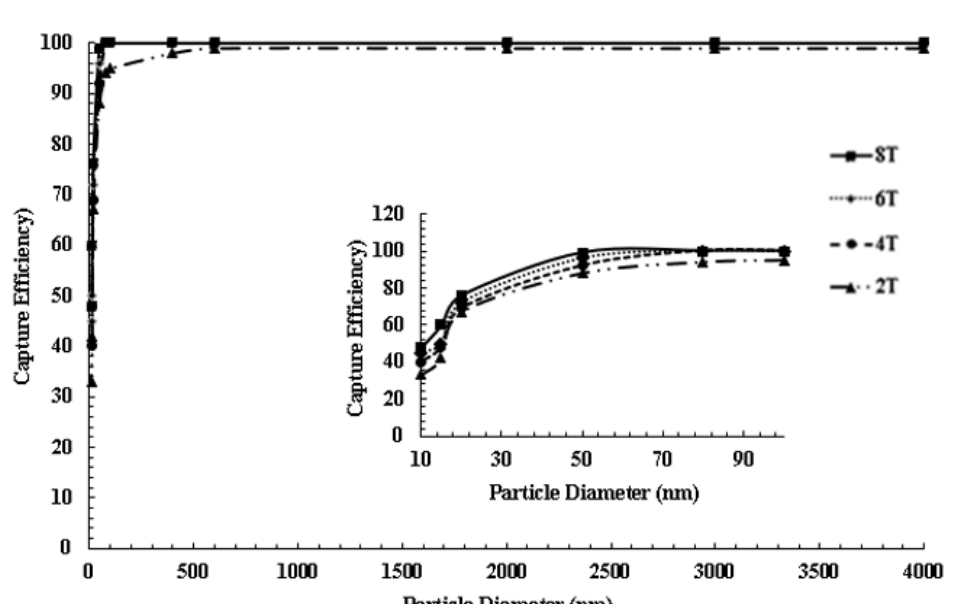
Figure 12. Plot of capture efficiency as a function of particle diameter in the simulated arterial flow. The inset shows the efficiency of MDT in the superparamagnetic regime.